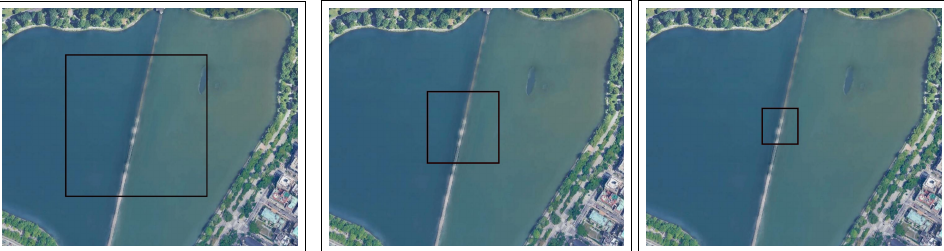
Figure 8. Terrain test for the Central Park Lake location (location #2) from altitudes of: 200 m (in the left image), 100 m (in the center image), 50 m (in the right